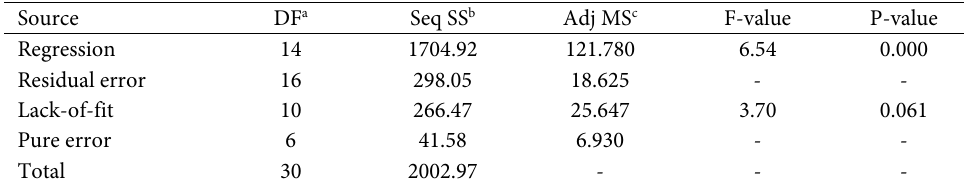
Table 2. Analysis of variance (ANOVA) for the developed model.